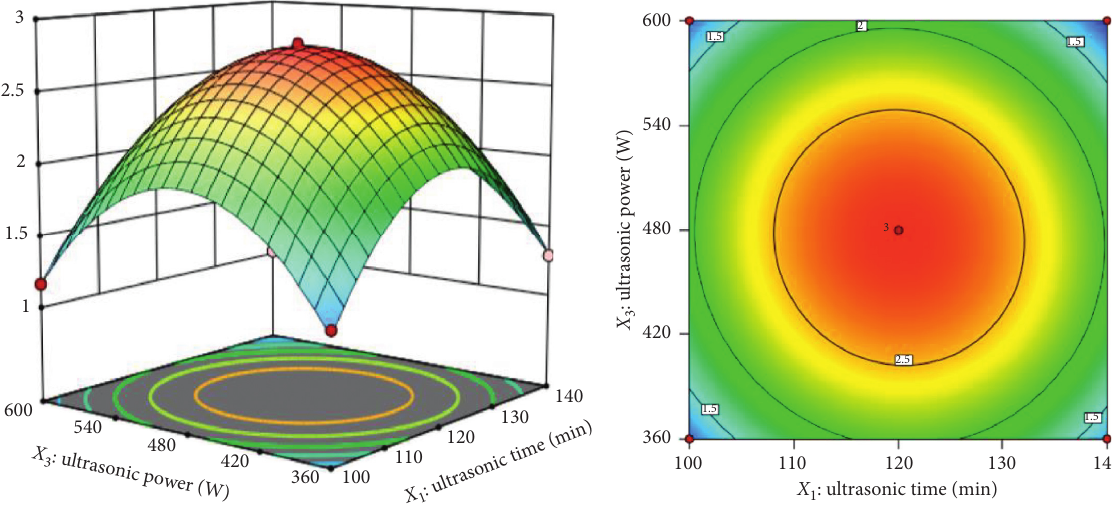
Figure 9: Simultaneous effect of ultrasonic time and ultrasonic